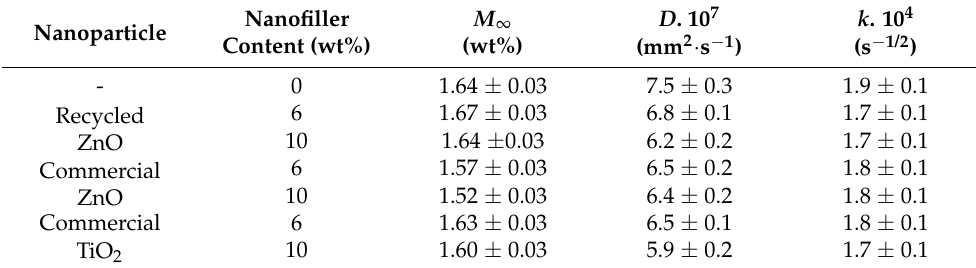
Table 1. Water absorption parameters of epoxy and